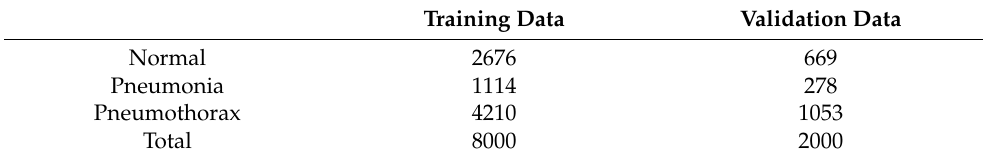
Table 1. NIH dataset.